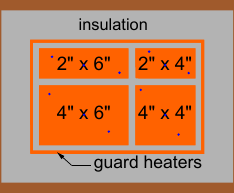
Figure 4. Top view of the insulated box. The blue dots indicate the locations of the thermocouples.